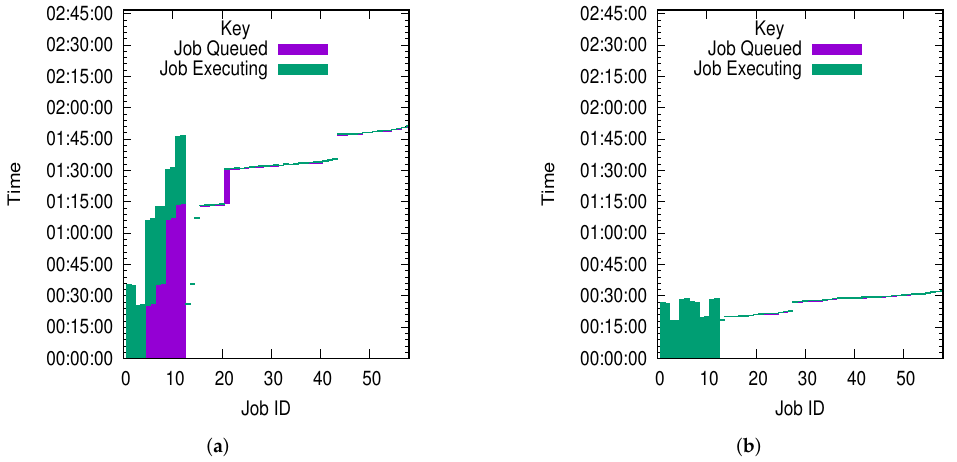
Figure 4. Execution of a 0.5 degree workflow on a 1 node vs. 6 node cluster: ( a ) 0.5 degree Montage on a small cluster; ( b ) 0.5 degree Montage on a large cluster.